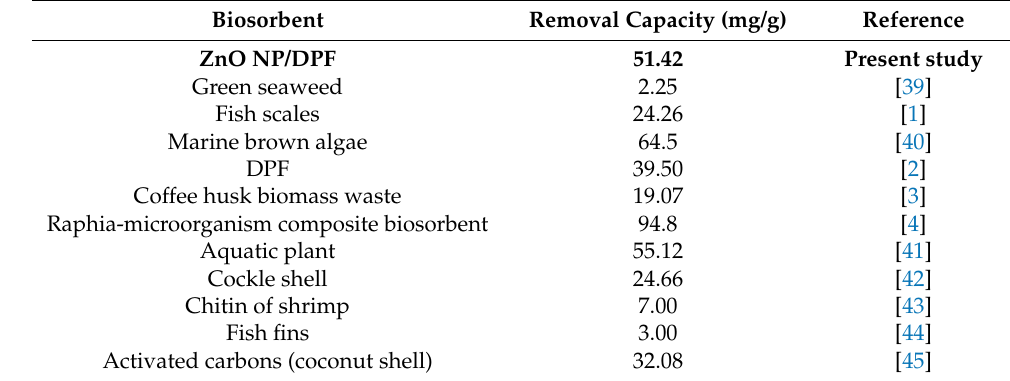
Table 4. Comparison of the removal capacities of various biosorbents in terms of lead ions.